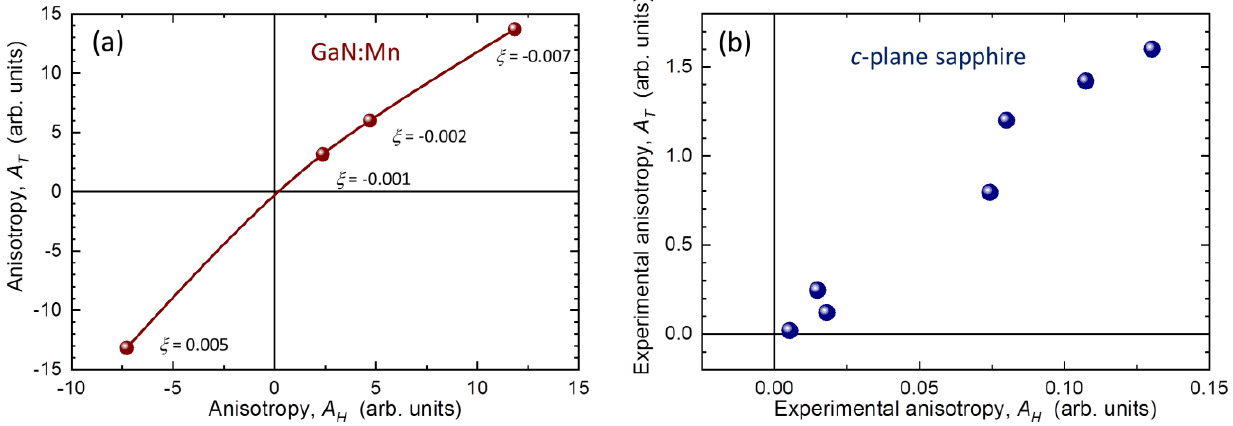
Figure 4. ( a ) Magnitudes A H and A T of the hatched areas between the branches of m ( T ) and m ( H ) presented in Figure 3. Their signs represent the orientation of the magnetic anisotropy according to the labels in Figure 3a. The solid line is a guide for the eye. ( b ) The same as in ( a ), but calculated from experimental data for some of the sapphire samples tested in this study, including those presented in Figure 2. The sign conversion adopted here indicating the positive magnitudes of A H and A T in panel ( b ) means that the easy axis orientation of the experimental magnetic anisotropy in c -plane sapphire samples is perpendicular to the sample plane ( H c ).